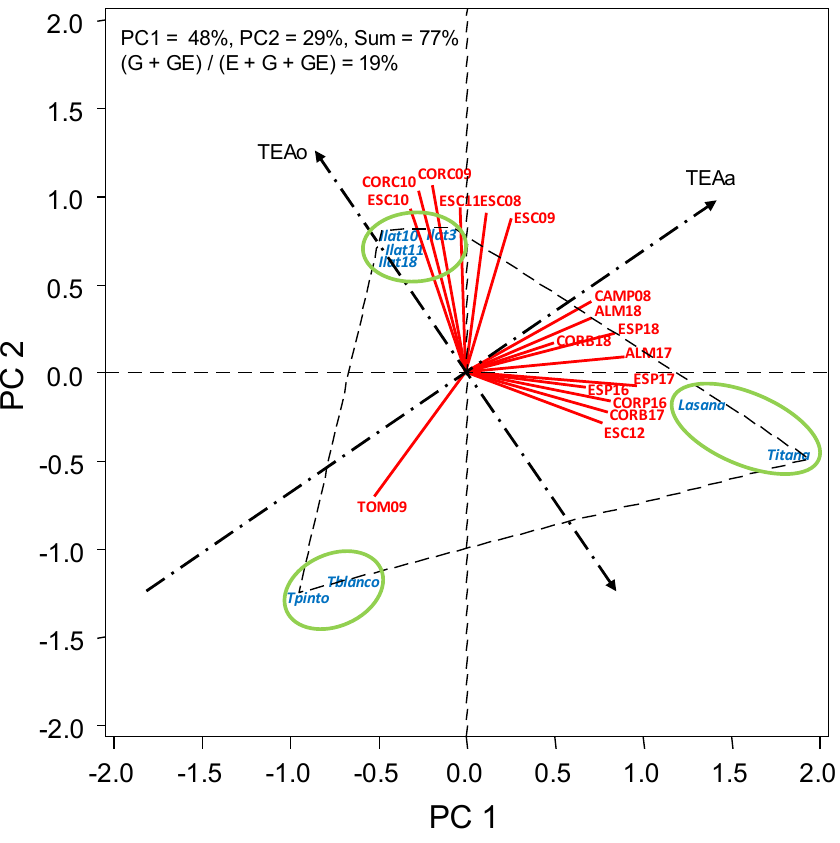
Figure 1. HA-GGE biplot based on yield (kg ha − 1 ) of 8 selected grass pea accessions in 17 environments (combination location–year). The genotypes are in italics and the environments are abbreviated as in Table 1. TEAa is the target environment axis abscissa and TEAo is the target environment axis ordinate.